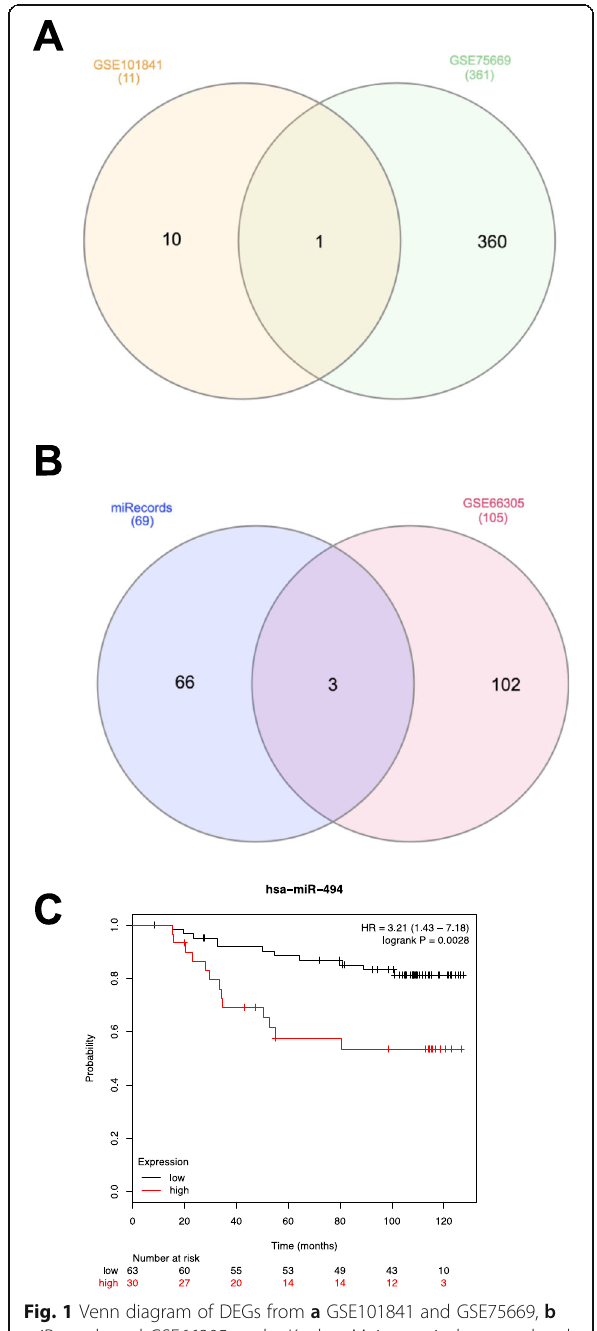
Fig. 1 Venn diagram of DEGs from a GSE101841 and GSE75669, b miRecords and GSE66305, and c Kaplan – Meier survival curve related to miR-494 level in the breast cancer